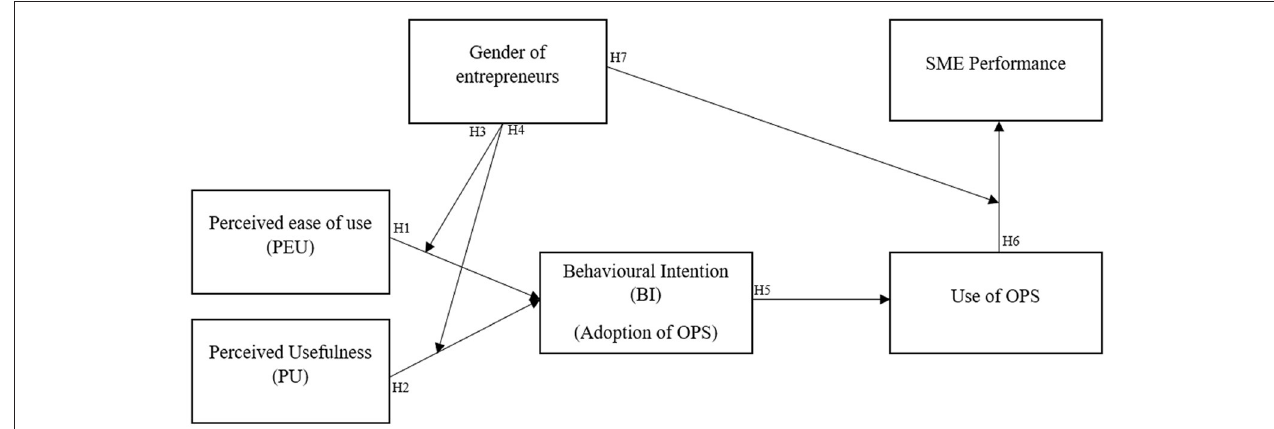
FIGURE 1 | Research